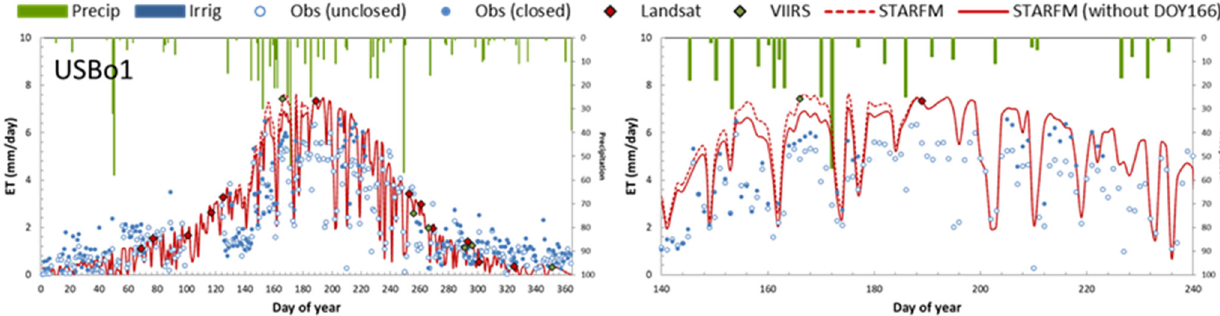
Figure 17. Comparison in the modeled ET time-series between with (dashed red line) and without (solid red line) DOY 166 at the USBo1 tower site of Bondville domain for the full year of 2018 ( left ) and peak growing season (DOY 140–240; right ).